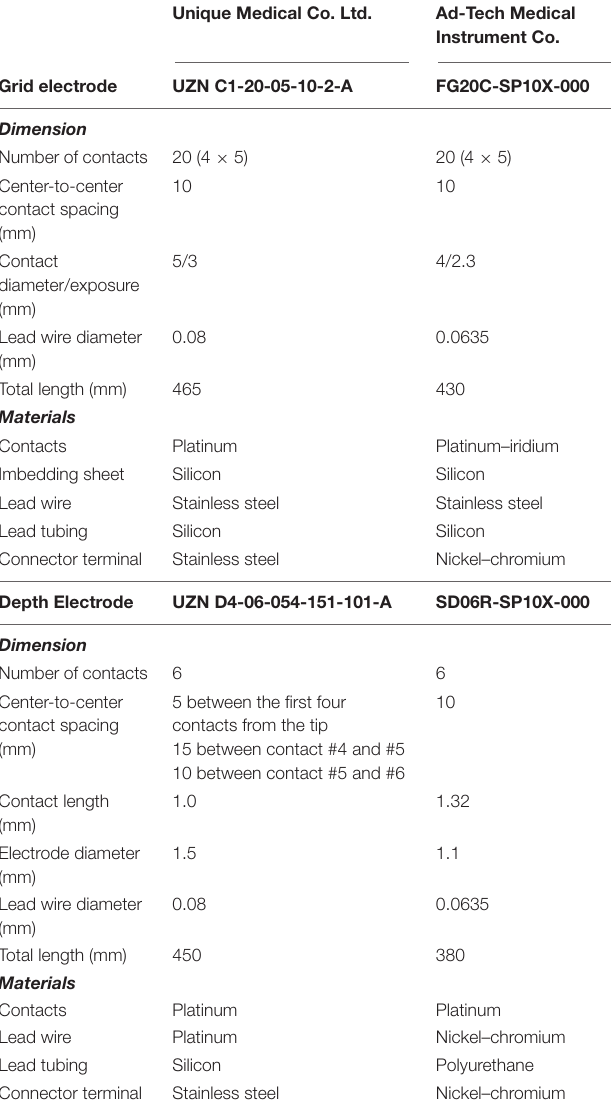
TABLE 1 | Materials and dimension of the electrodes used. Unique Medical Co. Ltd. Ad-Tech Medical Instrument